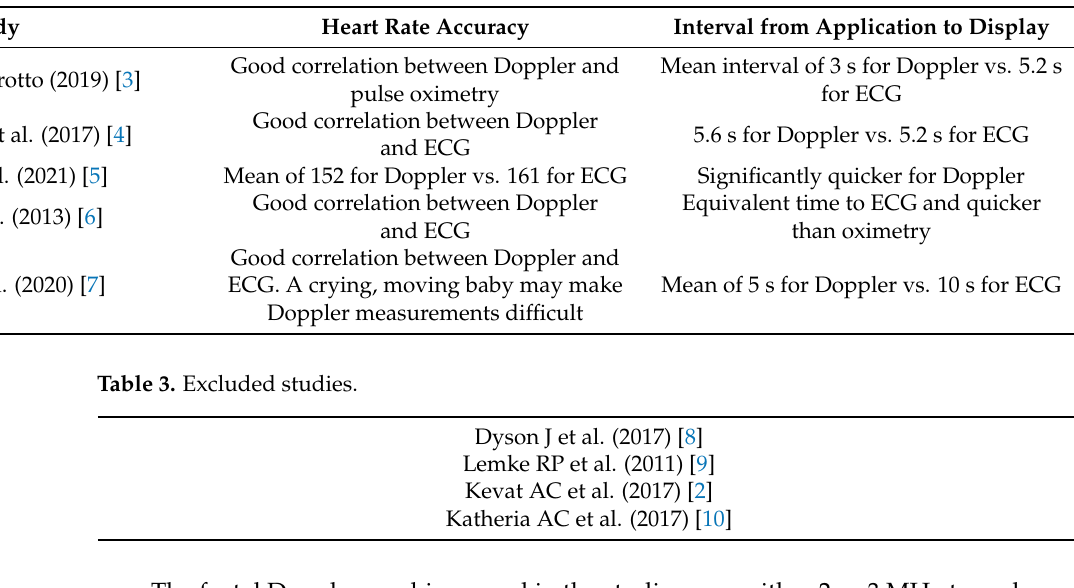
Table 2. Human studies included in the review.